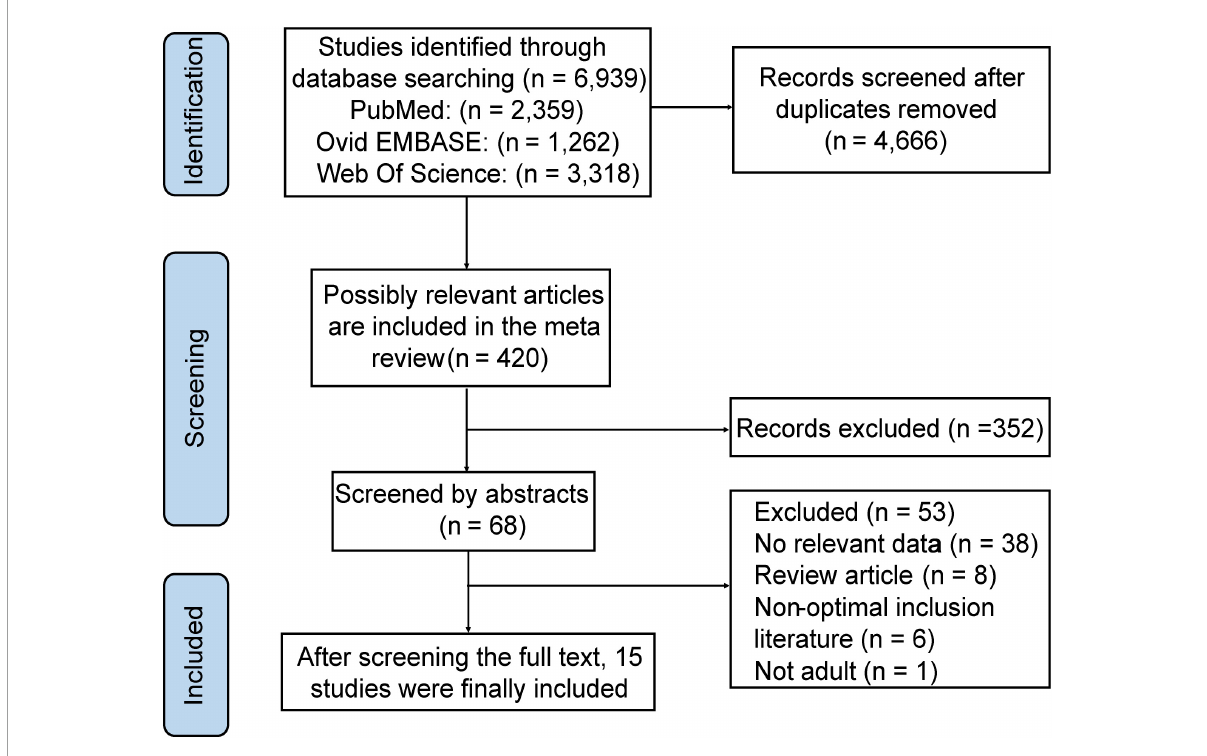
FIGURE1 Flowchart of the records retrieved, screened, and included in the